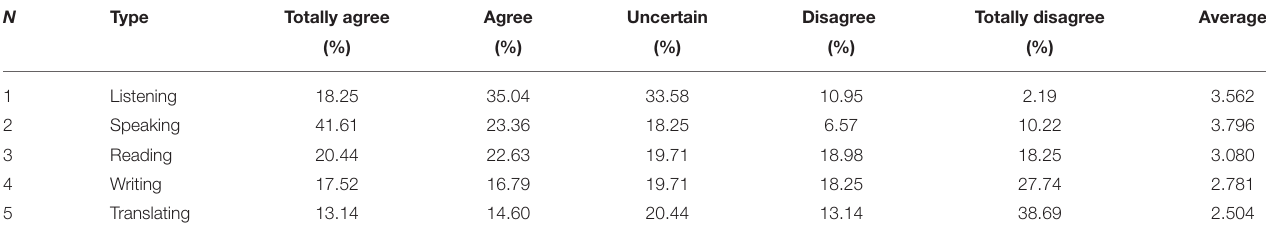
TABLE 2 | The statistics of students’ anxiety in language